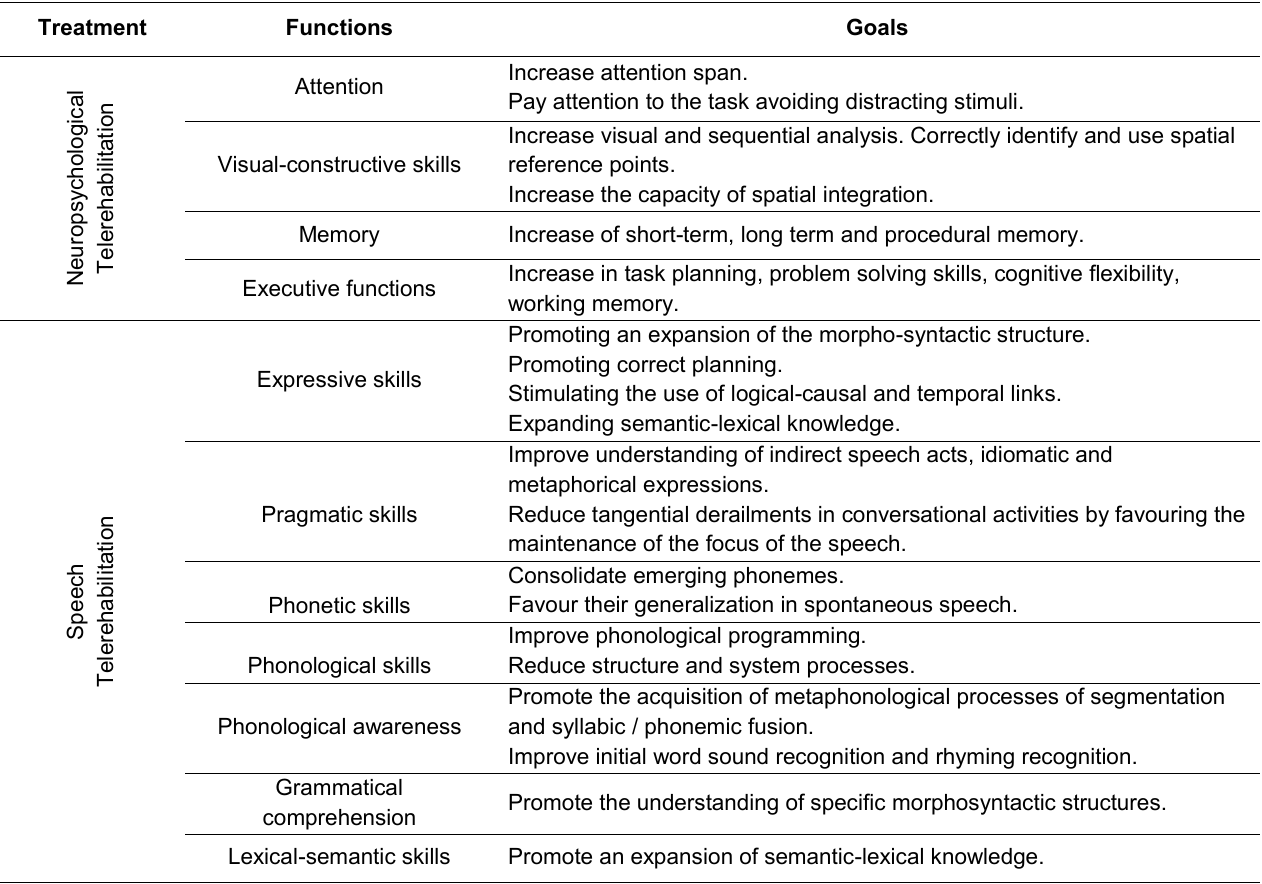
Table 2 Goals of Intervention for Each Function Treated in Neuropsychological and Speech Telerehabilitation Treatment Functions Goals Increase attention span. Attention Pay attention to the task avoiding distracting stimuli. Increase visual and sequential analysis. Correctly identify and use spatial Visual-constructive skills reference points. Increase the capacity of spatial